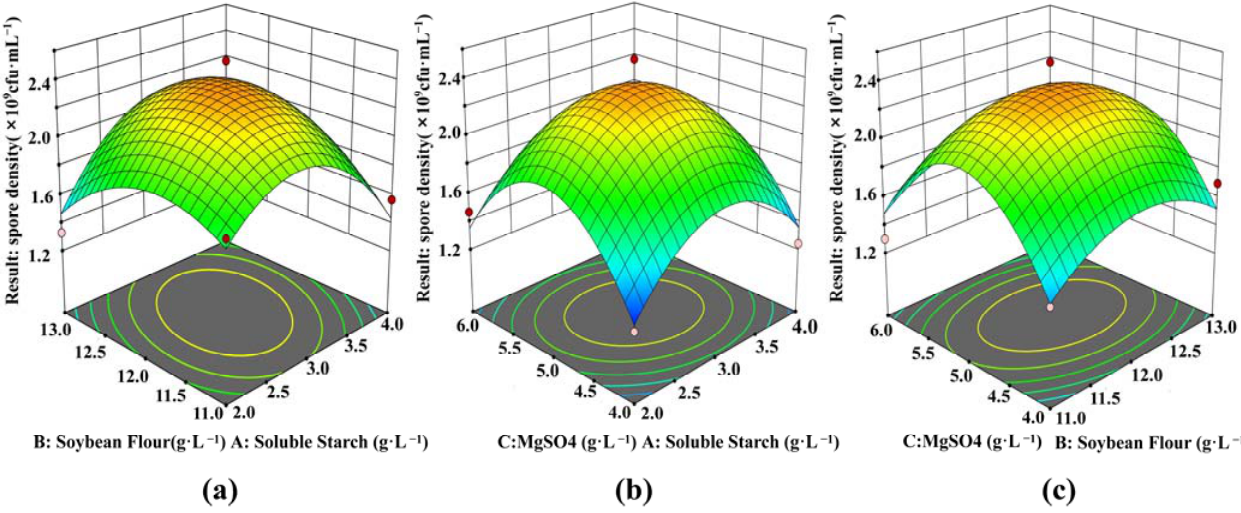
Figure 2. Response surface interaction influence surface diagram. Effects of soybean flour and soluble starch on spore formation ( a ); Effects of MgSO 4 and soluble starch on spore formation ( b ); Effects of MgSO 4 and soybean on spore formation ( c ).